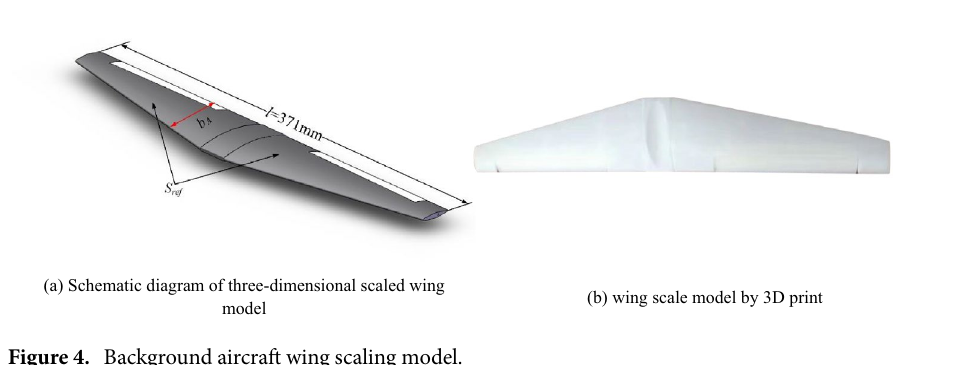
Figure 4. Background aircraft wing scaling